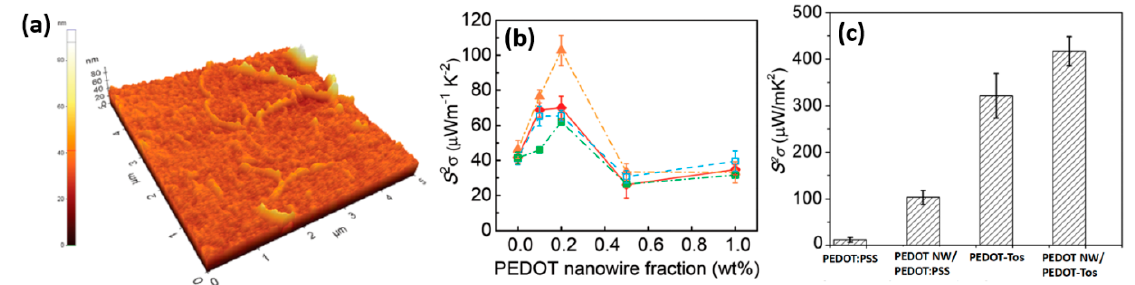
Figure 15. ( a ) The AFM image of 1 wt% PEDOT nanowire/PEDOT:PSS nanocomposites showing the random distribution of PEDOT nanowires in the PEDOT:PSS matrix and percolated networks. ( b ) Thermoelectric power factor of PEDOT nanowire/PEDOT:PSS hybrids. ( c ) Power factors of (from left to right) the as-prepared 5 vol% DMSO/PEDOT:PSS, nominal 0.2 wt% PEDOT nanowire/PEDOT:PSS with ethylene glocyl treatment, the as-synthesized PEDOT:Tos, and nominal 0.2 wt% PEDOT nanowire/PEDOT:Tos nanocomposites. Readapted with permission from The Royal Society of Chemistry [104].